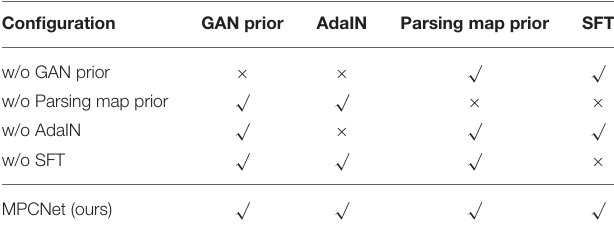
TABLE 1 | Summary of model characteristics presented in the ablation study.